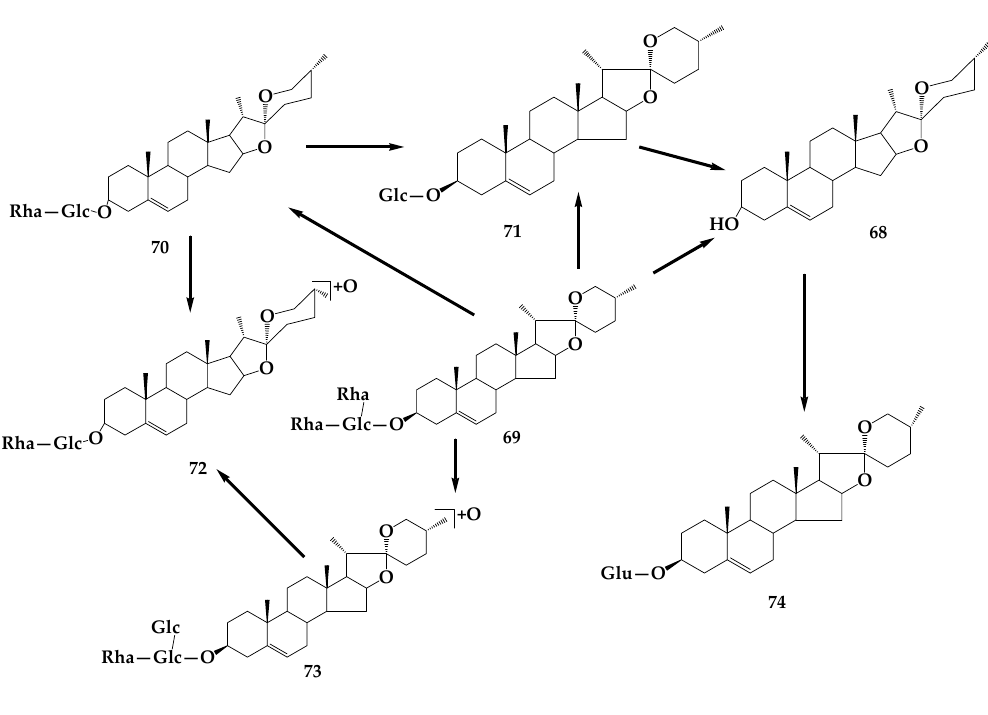
Figure 14. Transformation of diosgenin in rat intestinal flora.